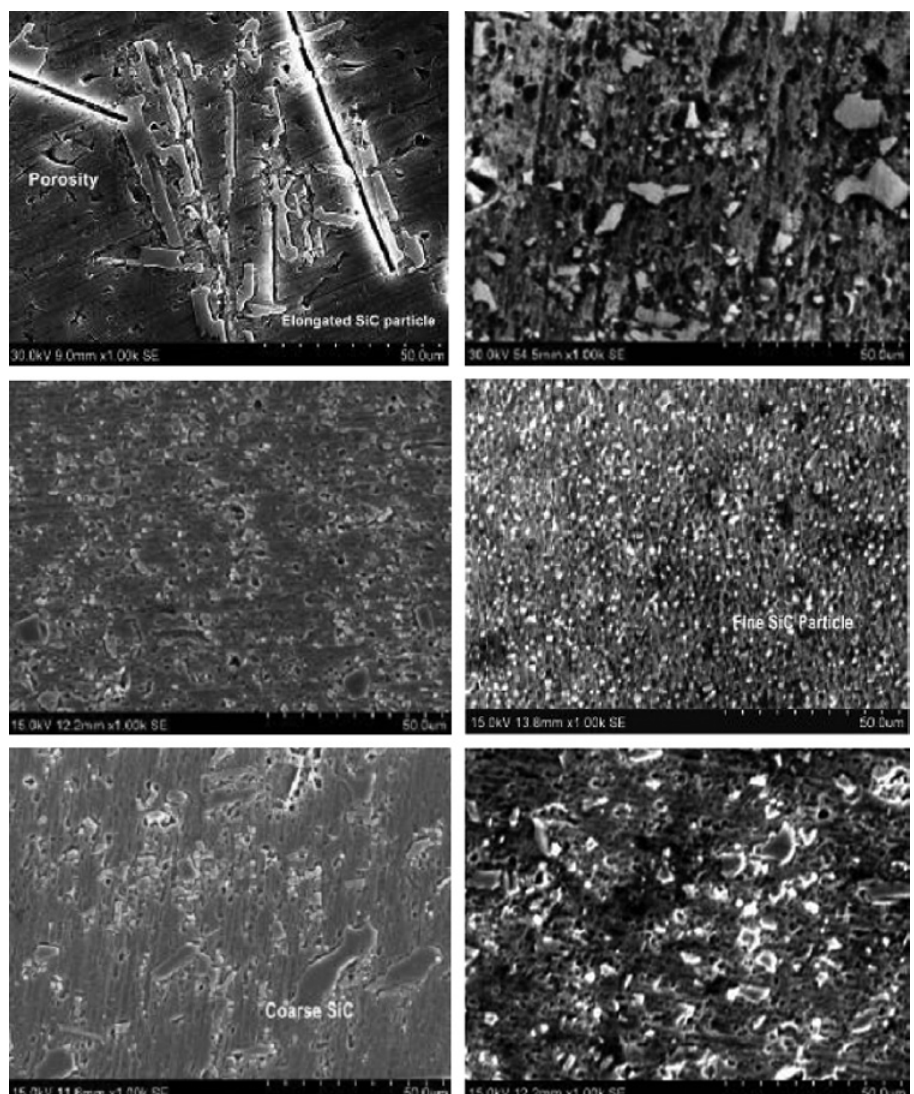
Figure 3: Effect of TVR on stir zone microstructural